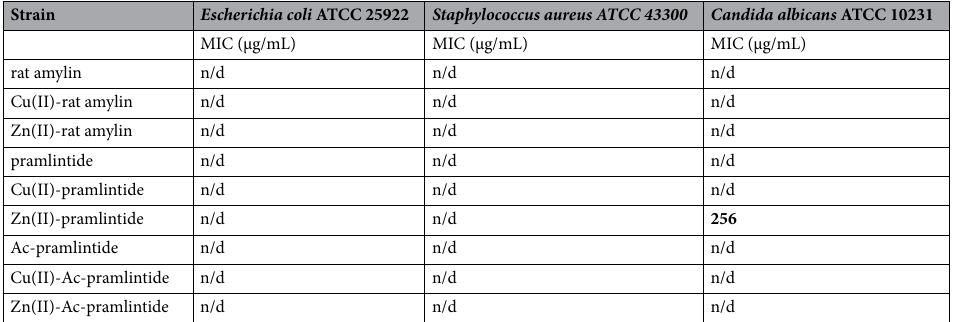
Table 1. In vitro antimicrobial activity of rat islet amyloid polypeptide, pramlintide and pramlintide acetate (rat amylin, pramlintide and Ac-pramlintide, respectively) with or without copper/zinc ions, expressed as a minimal inhibitory concentration (MIC) (µg/mL); n/d, not determined. No MBC/MFC activity was observed after performing modified Richard’s methodl 37–39 . Significant values are in